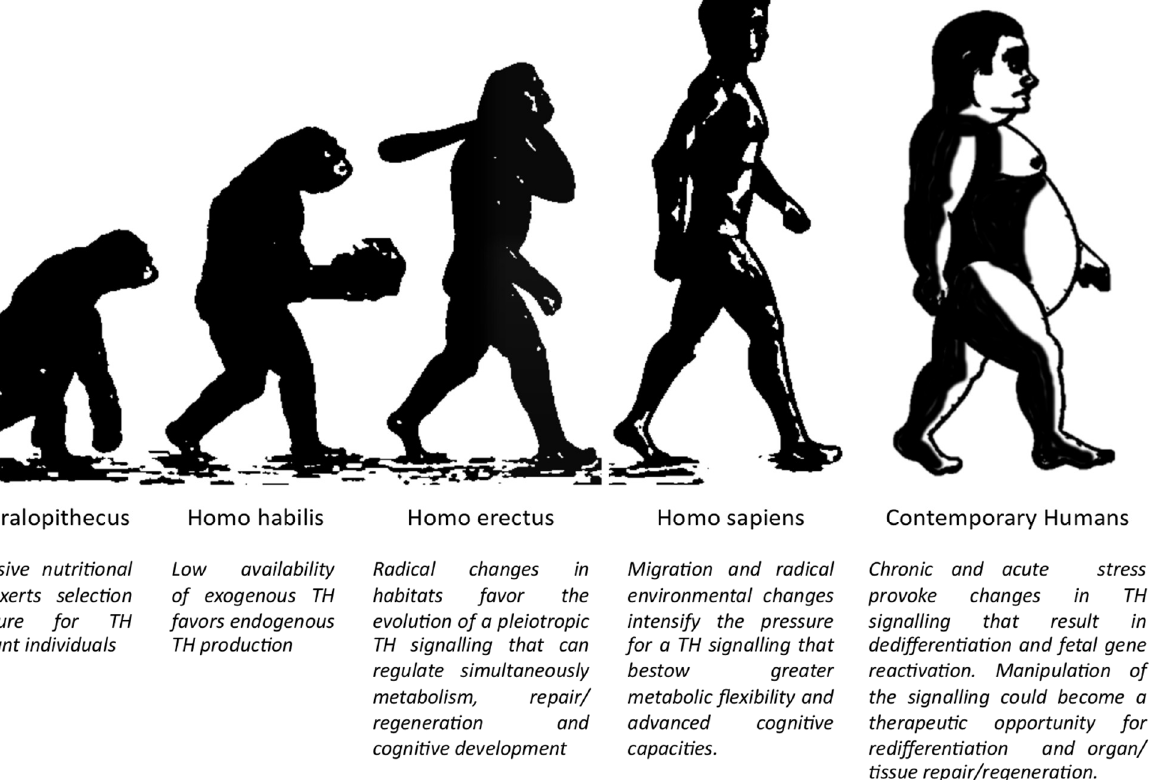
Figure 1. The key role of TH signalling in human evolution and disease. (Modified from Biologiwise.com accessed on 27 October).